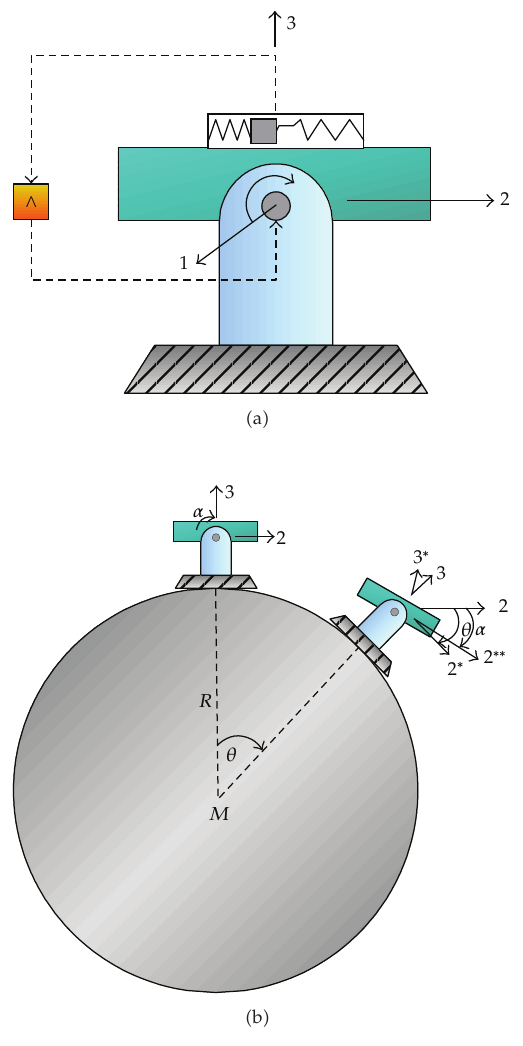
Figure 1: (cid:2) a (cid:3) The horizontal platform system. (cid:2) b (cid:3) The horizontal platform system on the